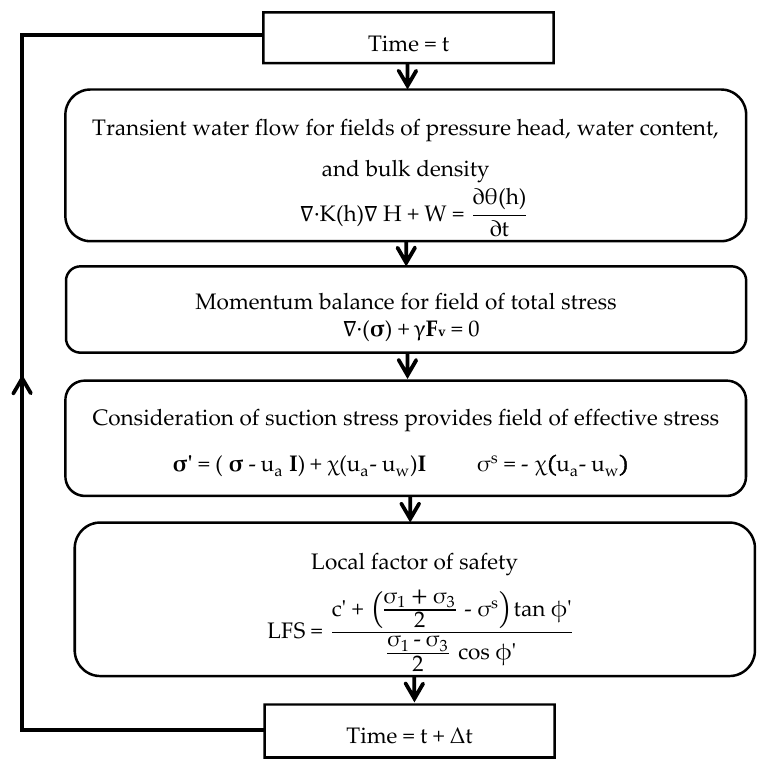
Figure 1. Workflow of the one-way coupled hydromechanical framework following Lu et al. [30].